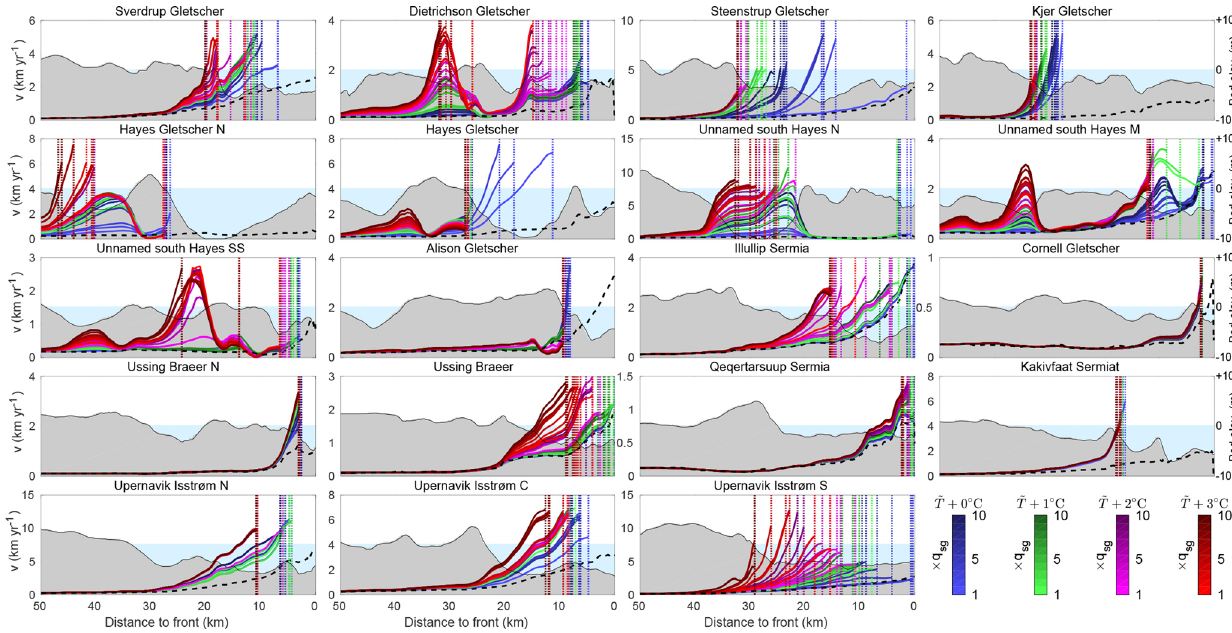
Figure 5. Modeled ice velocities (solid lines) and ice front positions (dashed vertical lines) in 2030 for all 40 scenarios. The black dashed line is the current ice velocity (m) and the x axis shows the distance to the current calving-front position.